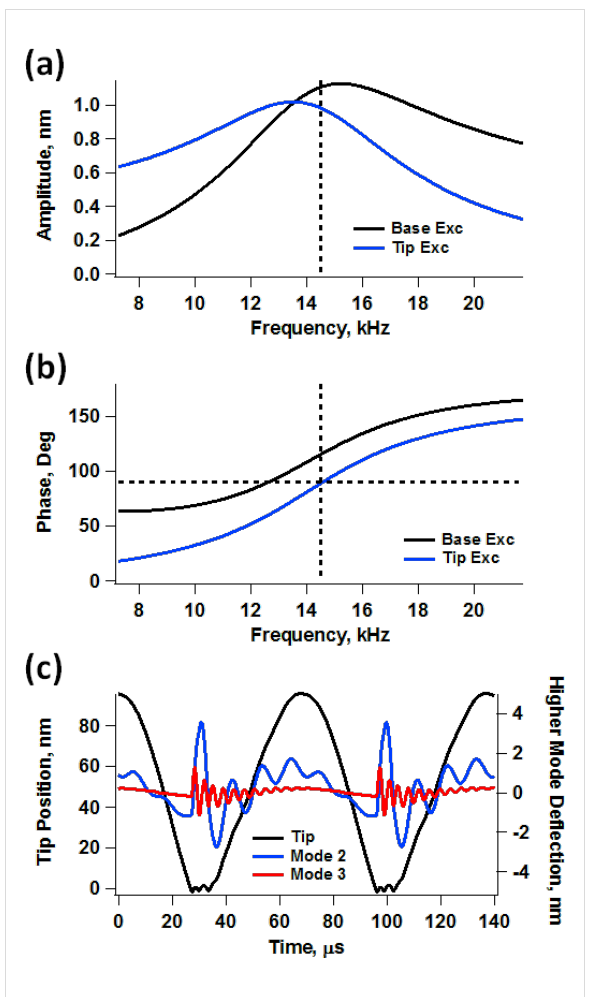
Figure 1: Example of measurement artifacts previously observed in single-mode AFM operation in liquids: distortion of the frequency response (a) and phase response (b) curves with base excitation (the “Tip Exc” traces provide the true response); momentary excitation of higher eigenmodes and multiple tip–sample impacts for every cycle of the fundamental eigenmode (c). The simulation parameters are ν 1